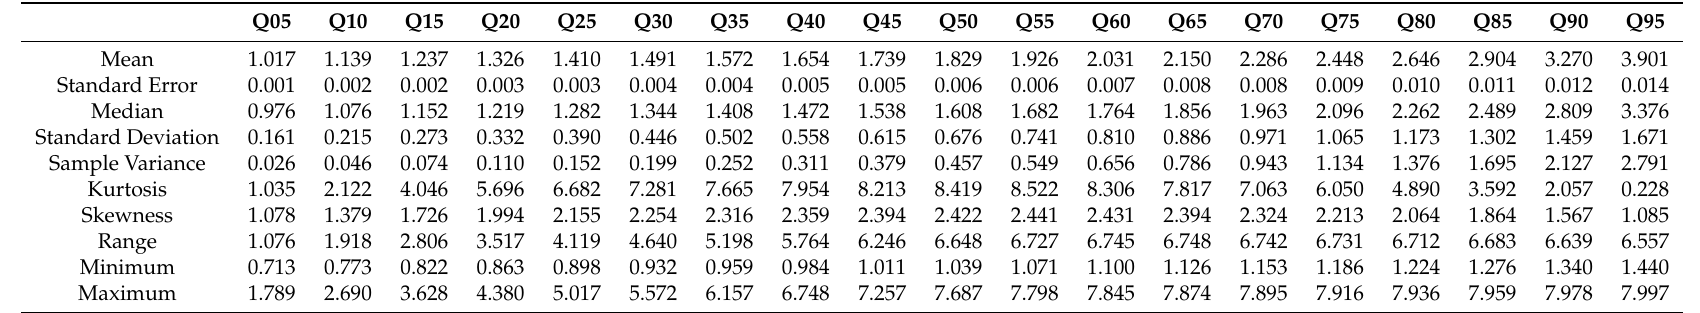
Table 6. Summary Statistics with Fitted values of Nonparametric Copula based Quantile